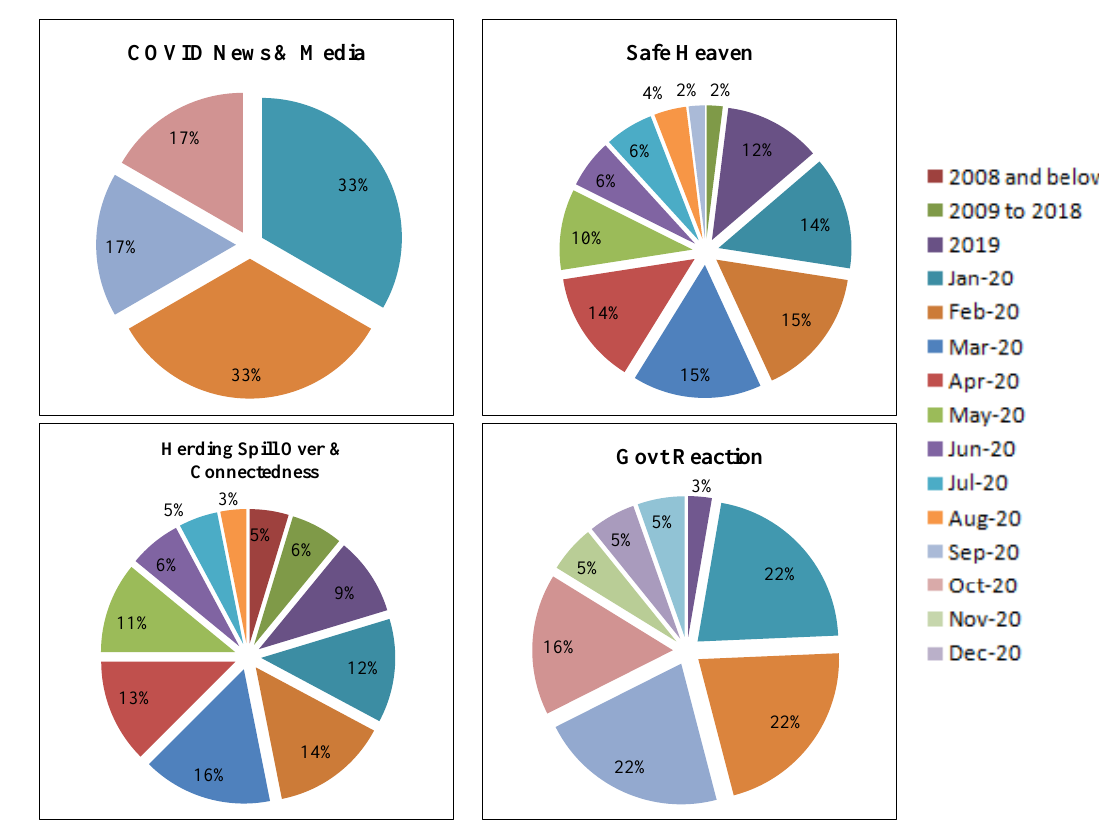
Figure 10. Themes of Research used for Months/Periods of